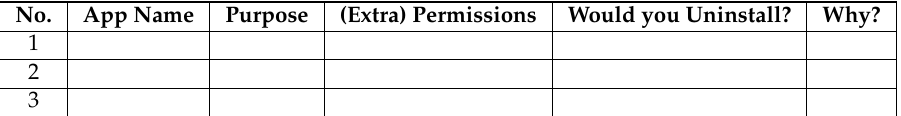
Table A4. This form was used for Activity 8.